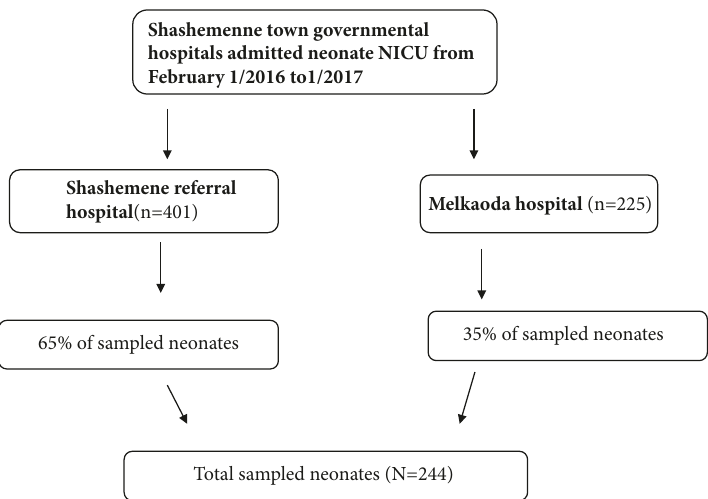
Figure 1: Schematic representation of sampling procedure of the study.